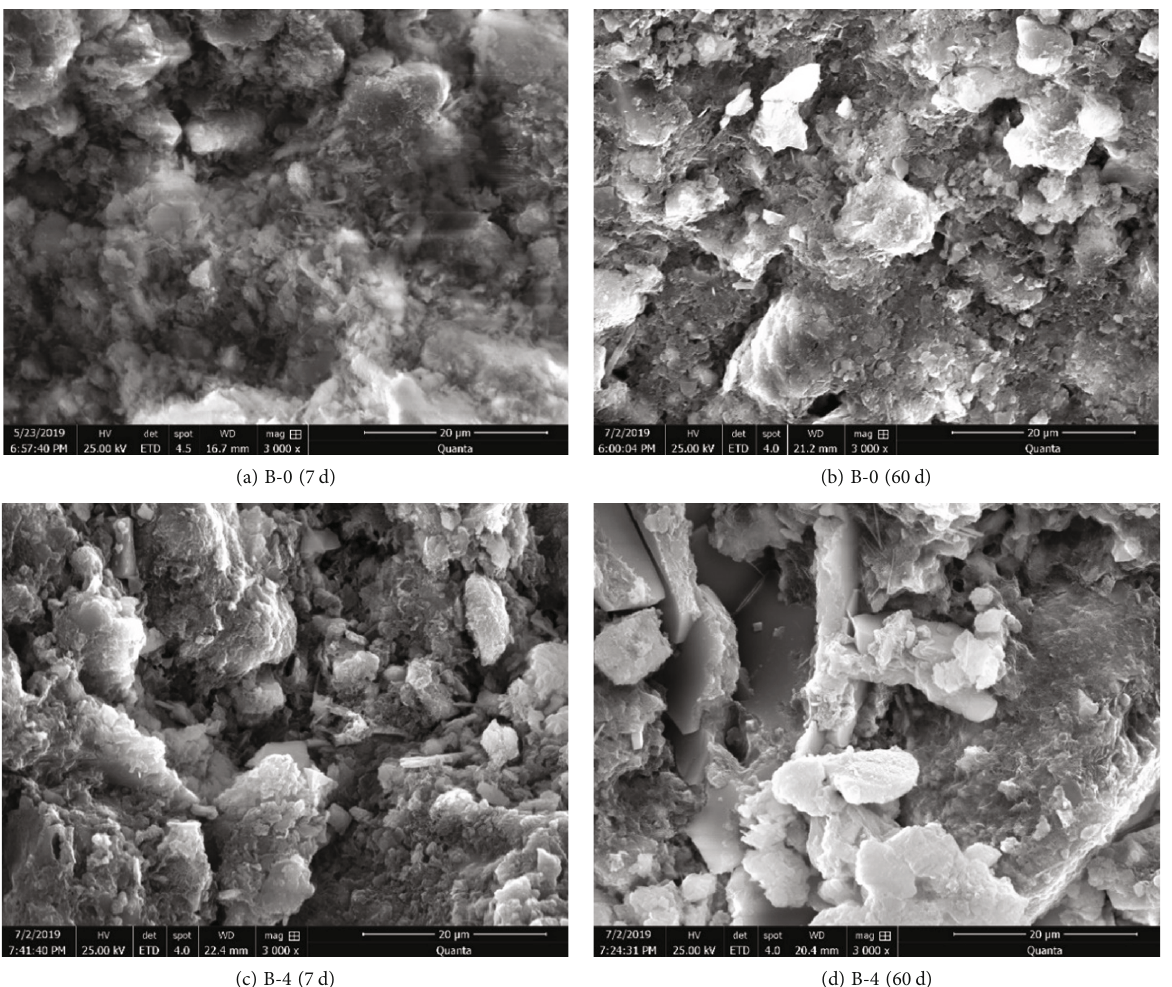
Figure 10: Microscopic morphology of soil-cement: (a) SEM image of B-0 at 7 days ( × 3000); (b) SEM image of B-0 at 60 days ( × 3000); (c) SEM image of B-4 at 7 days ( × 3000); (d) SEM image of B-4 at 60 days ( ×